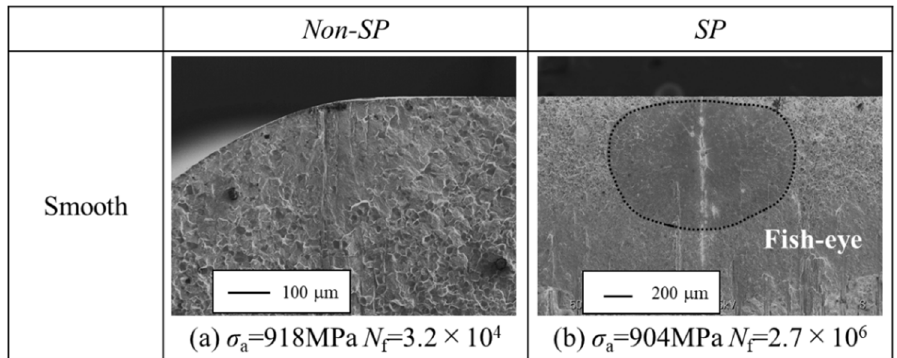
Figure 8. Fracture surface observation results of smooth